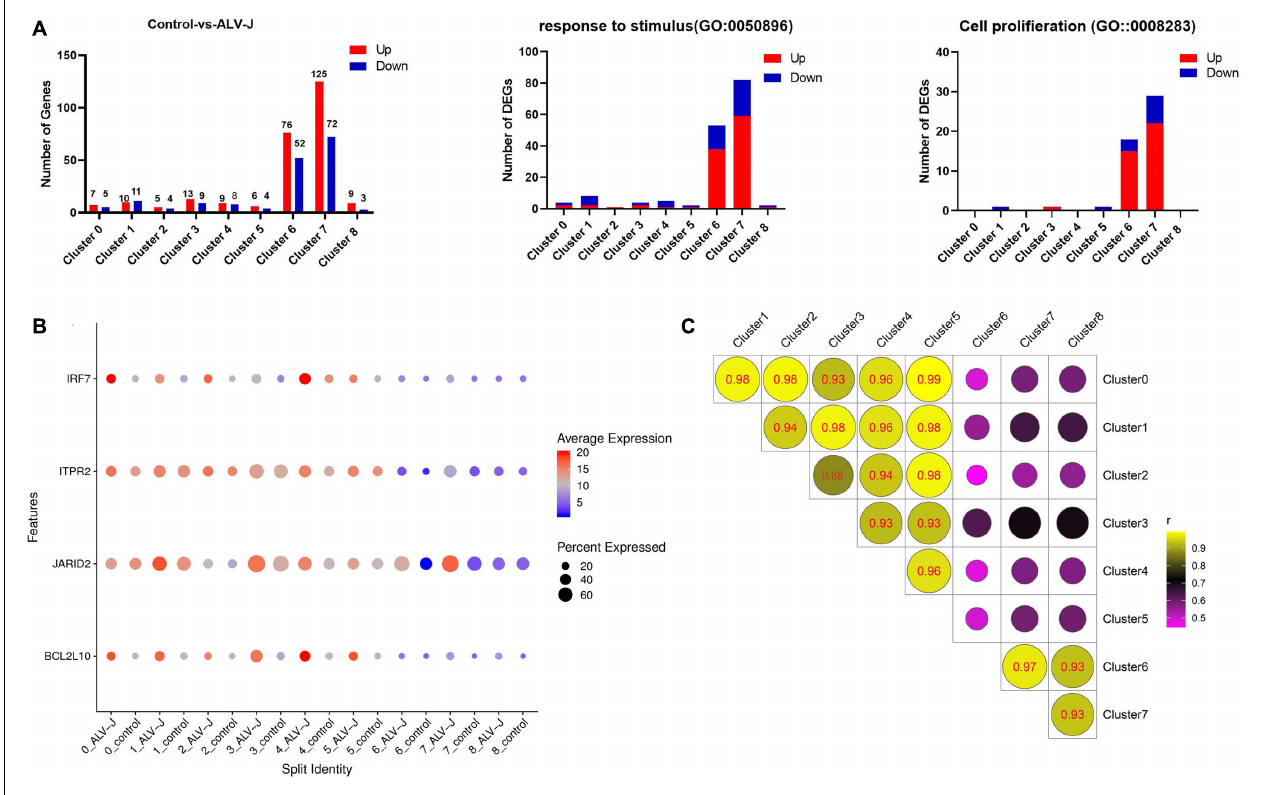
FIGURE 3 | Differentially expressed gene (DEG) analysis in PBMCs from ALV-J infected and control chickens within cell populations . (A) Bar graphs showing all up-regulated (red) and down-regulated (blue) DEGs, and the number of DEGs involved in the GO terms “response to stimulus” and “cell proliferation” in PBMCs from ALV-J infected chicken compared to control PBMCs within each cluster. (B) Dot plot representing selected DEGs ( IRF7 , ITPR2 , JARID2 , and BCL2L10 ) expressed in eight clusters within which cells from the ALV-J infected sample were compared with the control sample. The intensity represents the expression level, while dot size represents the proportion of cells expressing each gene. (C) Pearson’s Correlation analysis of different cell populations based on gene expression